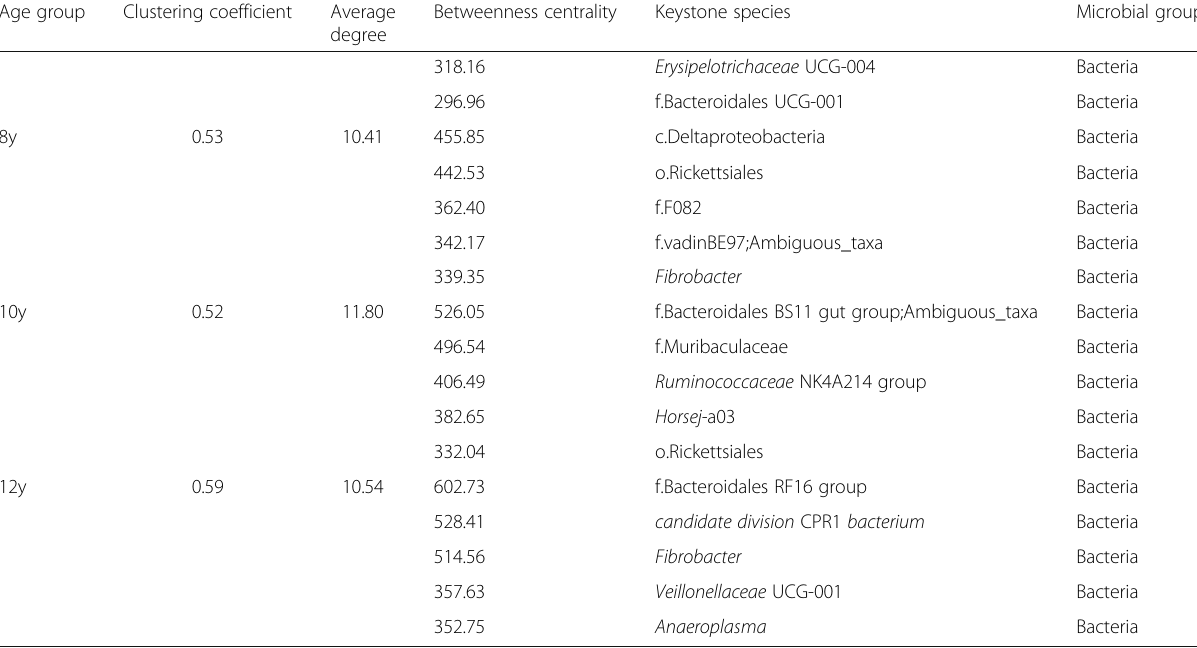
Table 3 Topological properties and keystone species of co-occurring networks of inter-kingdom interactions (Continued) Age